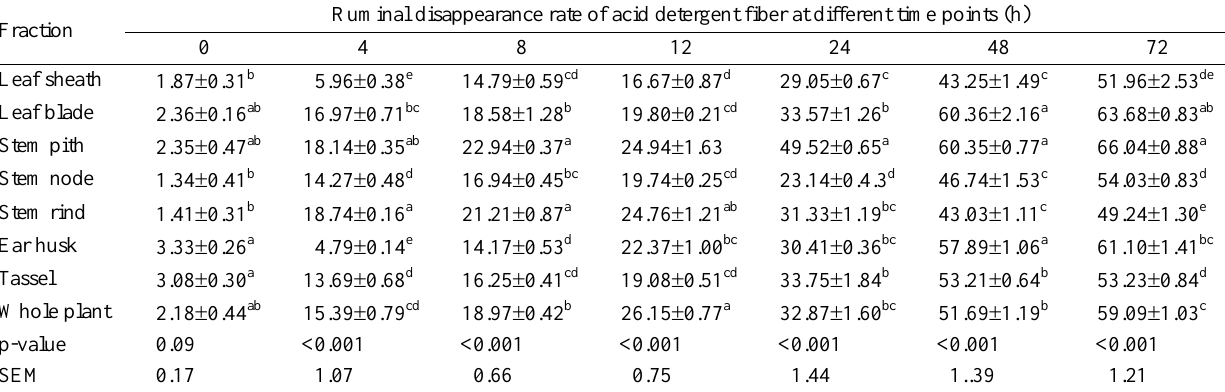
Table 4. Ruminal disappearance rate (%) of ADF from whole corn stover and different morphological fractions Fraction